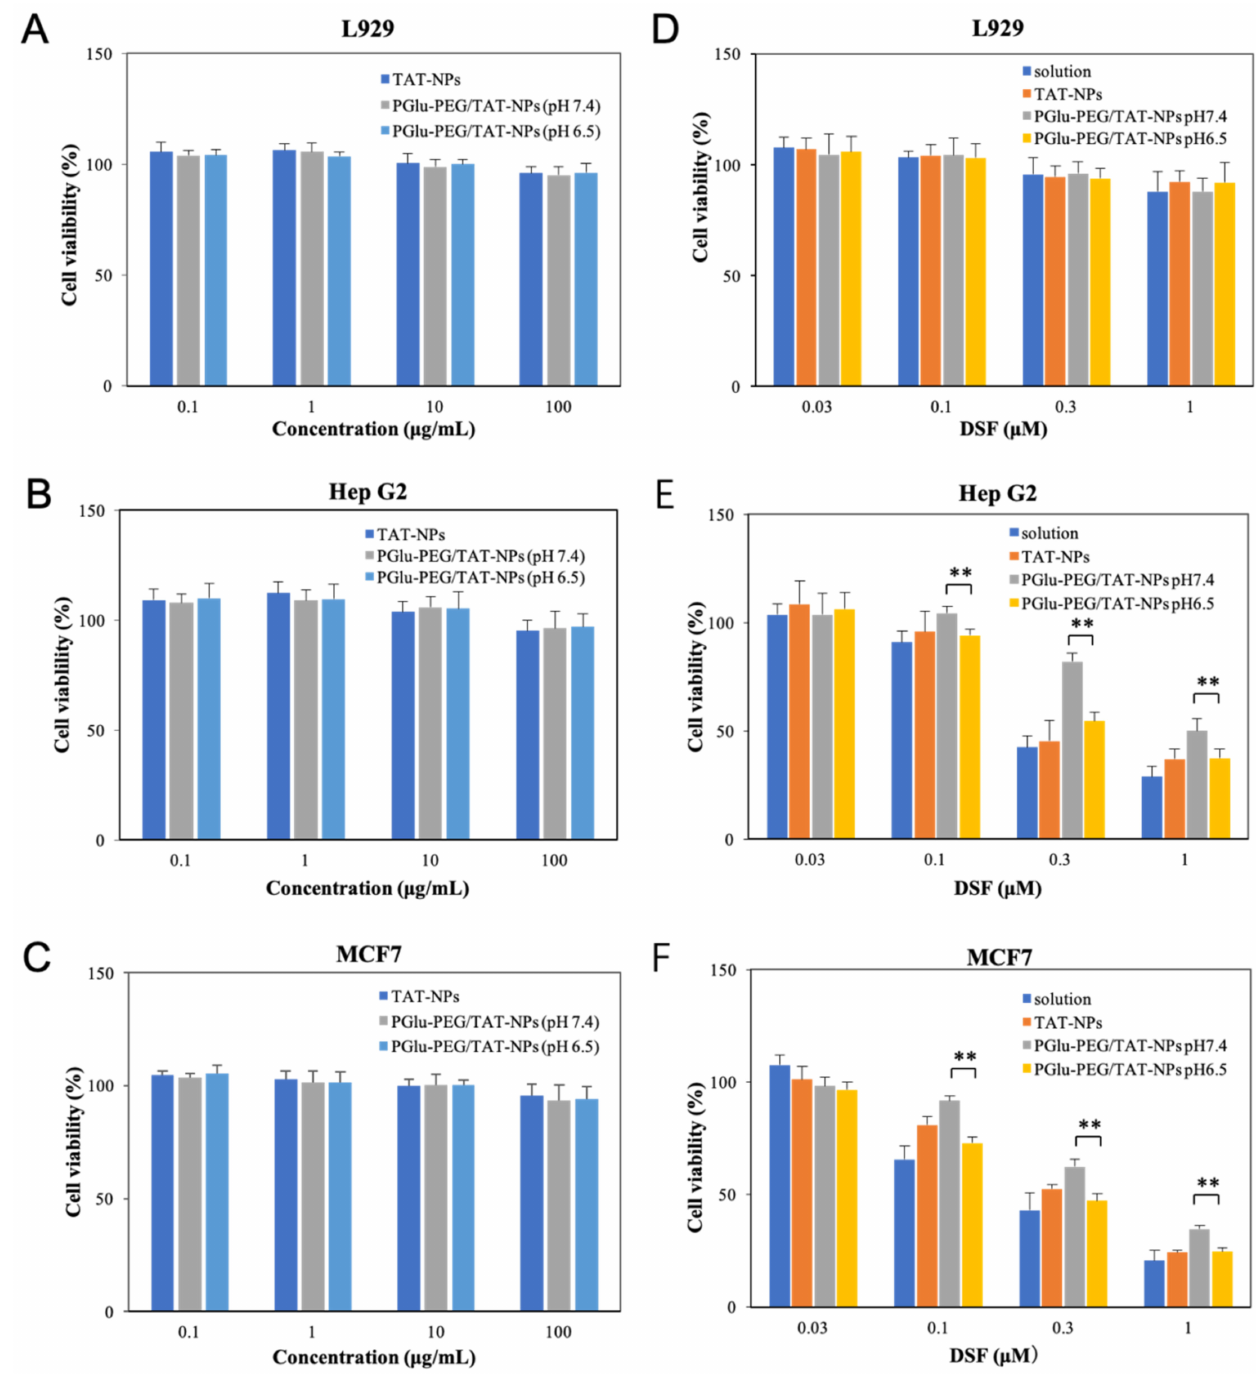
Figure 6. In vitro cytotoxicity of different preparations. Cell viability of L929 cells ( A ), Hep G2 cells ( B ), and MCF7 cells ( C ) after incubation with blank TAT-NPs and PGlu-PEG/TAT-NPs (pretreated with PBS of pH 7.4 or pH 6.5) for 24 h; cell viability of L929 cells ( D ), Hep G2 cells ( E ), and MCF7 cells ( F ) after incubation with DSF solution, DSF-loaded TAT-NPs, and DSF-loaded PGlu-PEG/TAT-NPs (pretreated with PBS of pH 7.4 or pH 6.5) for 24 h ( n = 3). ** p < 0.01. Solution: DSF dissolved in saline with a low content of Cremophor EL/ethanol. TAT-NPs: cationic nanoparticles with TAT modification; PGlu-PEG/TAT-NPs: shell/core composite nanoparticles with TAT and PGlu-PEG/TAT-NPs